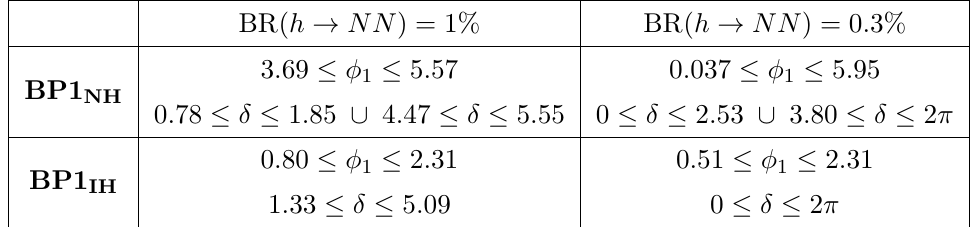
Table 6 . Range of parameters that can be probed in case of detection of a RH neutrino decay for the representative m N mass and BR( h → NN ) considered in figure 6. The range for φ 1 corresponds to the red lines in the figure, while the range for δ to the blue ones. In both case the other phase is kept fixed to the benchmark point